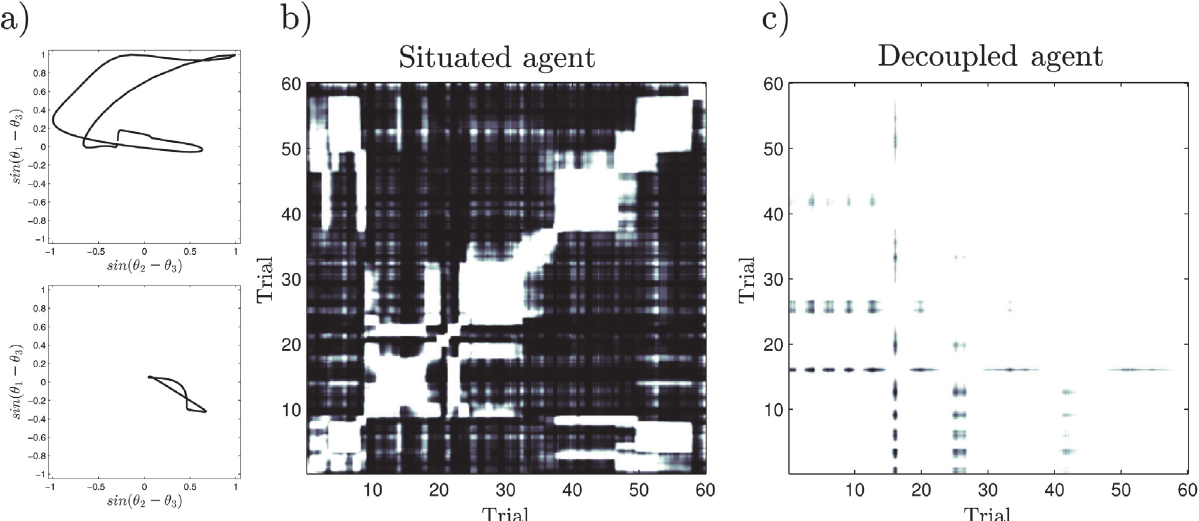
Fig 5. Correlation analysis of the dynamical patterns emerging from the neural controller. We analyze the patterns at different moments for the situated and decoupled agents. In a) we observe different examples of patterns emerging from the situated agent for trials 5 and 15. In b) and c) we observe the correlations between the joint density function of the patterns at different moments of a trial (white for correlation equal to one, black for zero correlation). Clusters of correlated patterns in b) describe the different emergent stable behavioural patterns corresponding to particular preference modes of the situated agent. For the decoupled agent we do not find different clusters of stable behavioural